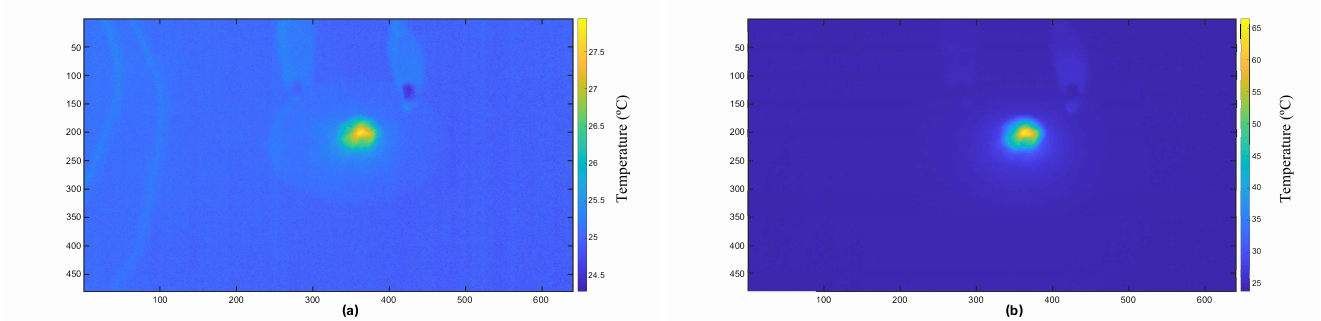
Figure 6. Examples of images of the blue light-emitting diode (LED) driven at different currents, taken by a thermographic camera. ( a ) LED at 10 mA and ( b ) LED at 100 mA. Both X and Y axes correspond to